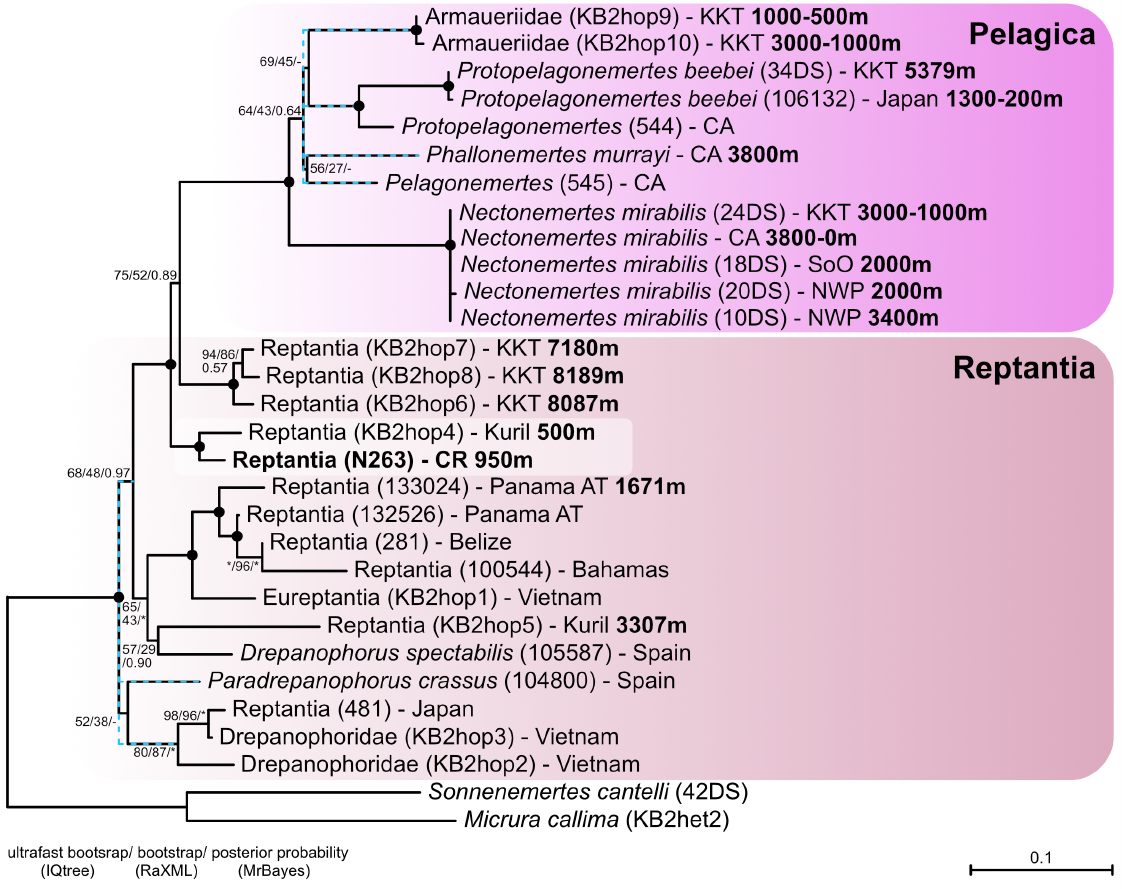
Fig. 6. Maximum likelihood (ML) tree for the polystiliferan supermatrix based on the concatenated four gene dataset (16S, COI, 18S, H3). Black circles indicate nodal support of 100/100/1.0; asterisks indicate nodal support of either 100/ or /1.0. Alternative branches found in the BI analysis are given as blue dotted lines. Sonnenemertes cantelli Chernyshev, Abukawa & Kajihara, 2015 and Micrura callima Sundberg & Gibson, 1995 were used for outgroup rooting. The reptant hoplonemertean specimen collected at the Costa Rica margin is given in bold. Specimen-ID, sampling locality, and depth (for deep-sea species) are